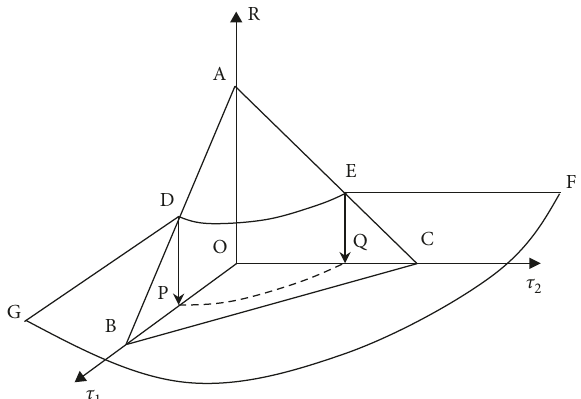
Figure 23: Three-dimensional curved face of the lateral ride index matrix R